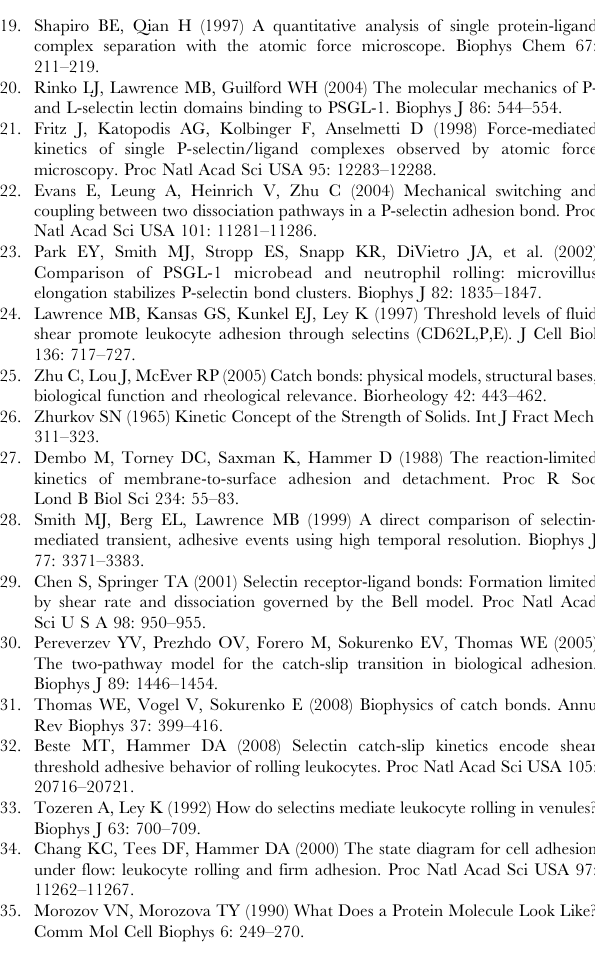
Figure S6 A model of encounter complex formation and bond formation. A model accounting for the role of both the molecular tether and binding pocket chemistry in bond formation is presented. The model can be employed with the assumption that the receptor and ligand are each confined by an immobile tether anchor point to a separate